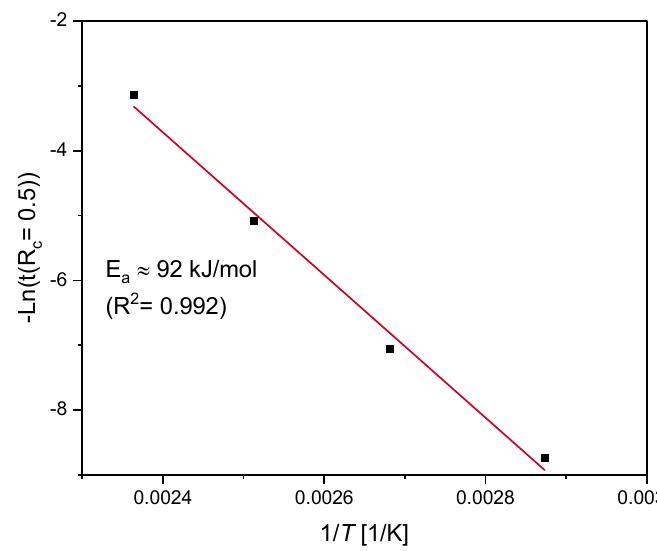
Figure 10. The Arrhenius plot for the relaxation half-times t ( R c = 0.5).